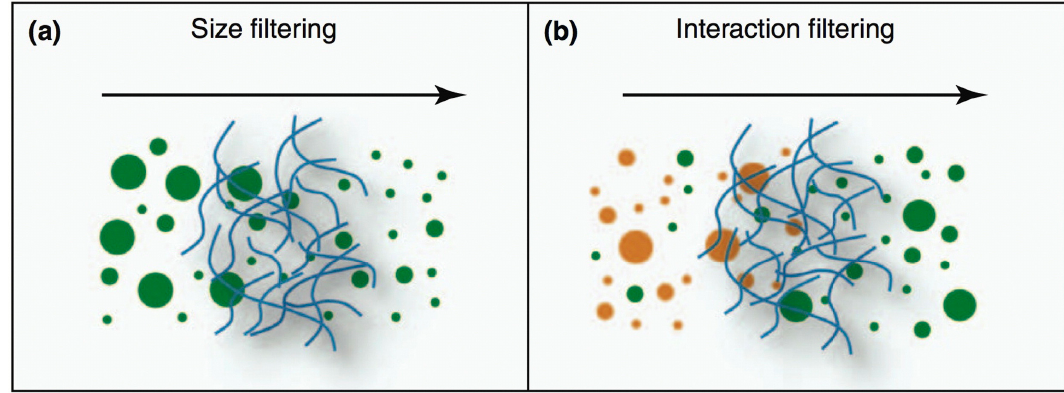
Figure 5. Major mechanisms hindering particles from diffusing through mucus: ( a ) Size filtering, by which only particles smaller than the mesh pores of the mucin fiber network can cross, whereas larger objects are blocked; ( b ) Interaction filtering, when particles behavior is different according to their surface properties: orange particles interacting strongly with the components of the mucus gel are trapped, whereas green particles showing weak interactions are allowed to go across (reproduced with permission from [121]).